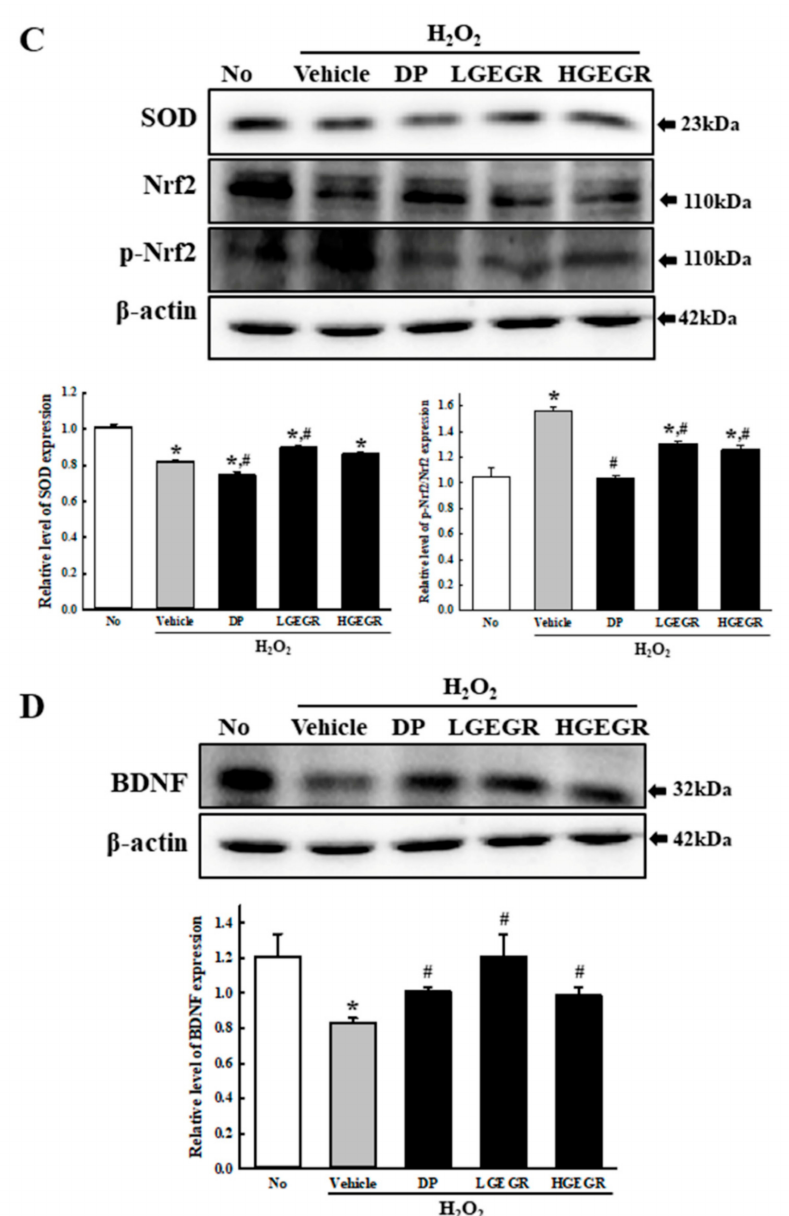
Figure 1. Anti-oxidant activity and BDNF secretion activity of GEGR in vitro. ( A ) Free radical scavenging activity of GEGR. DPPH radical scavenging activity was assayed in a mixture containing 0.1 mM DPPH within a range of GEGR concentrations from 1 to 2000 µ g / mL. ( B ) Determination of intracellular ROS production. After 2’,7’-dichlorofluorescein diacetate (DCFH-DA) treatment, green fluorescence in cells of each subset group was observed using a fluorescent microscope. B35 cells in each square of a 200 × magnification image (left column) were also examined under 400 × magnification (right column). ( C ) Detection of superoxide dismutase (SOD), Nrf2, and p-Nrf2 protein. Total tissue homogenates were prepared from brains of scopolamine (SP)-injected mice treated with Vehicle or GEGR as described in Materials and Methods. Three proteins were detected with specific antibody and quantified using an imaging densitometer. ( D ) Detection of brain-derived neurotrophic factor (BDNF) protein. Total tissue homogenates were prepared from brains of SP-injected mice treated with Vehicle or GEGR as described in Materials and Methods. BDNF protein was detected with specific antibody and quantified using an imaging densitometer. Three samples were assayed in duplicate by western blotting. * p < 0.05 compared with the No treated group. # p < 0.05 compared with the SP + Vehicle treated group. Abbreviation: DPPH, 2,2-diphenyl-1-picrylhydrazyl radical; IC 50 , half maximum inhibitory concentration; GEGR, gallotannin-enriched extract of Galla Rhois; ROS, reactive oxygen